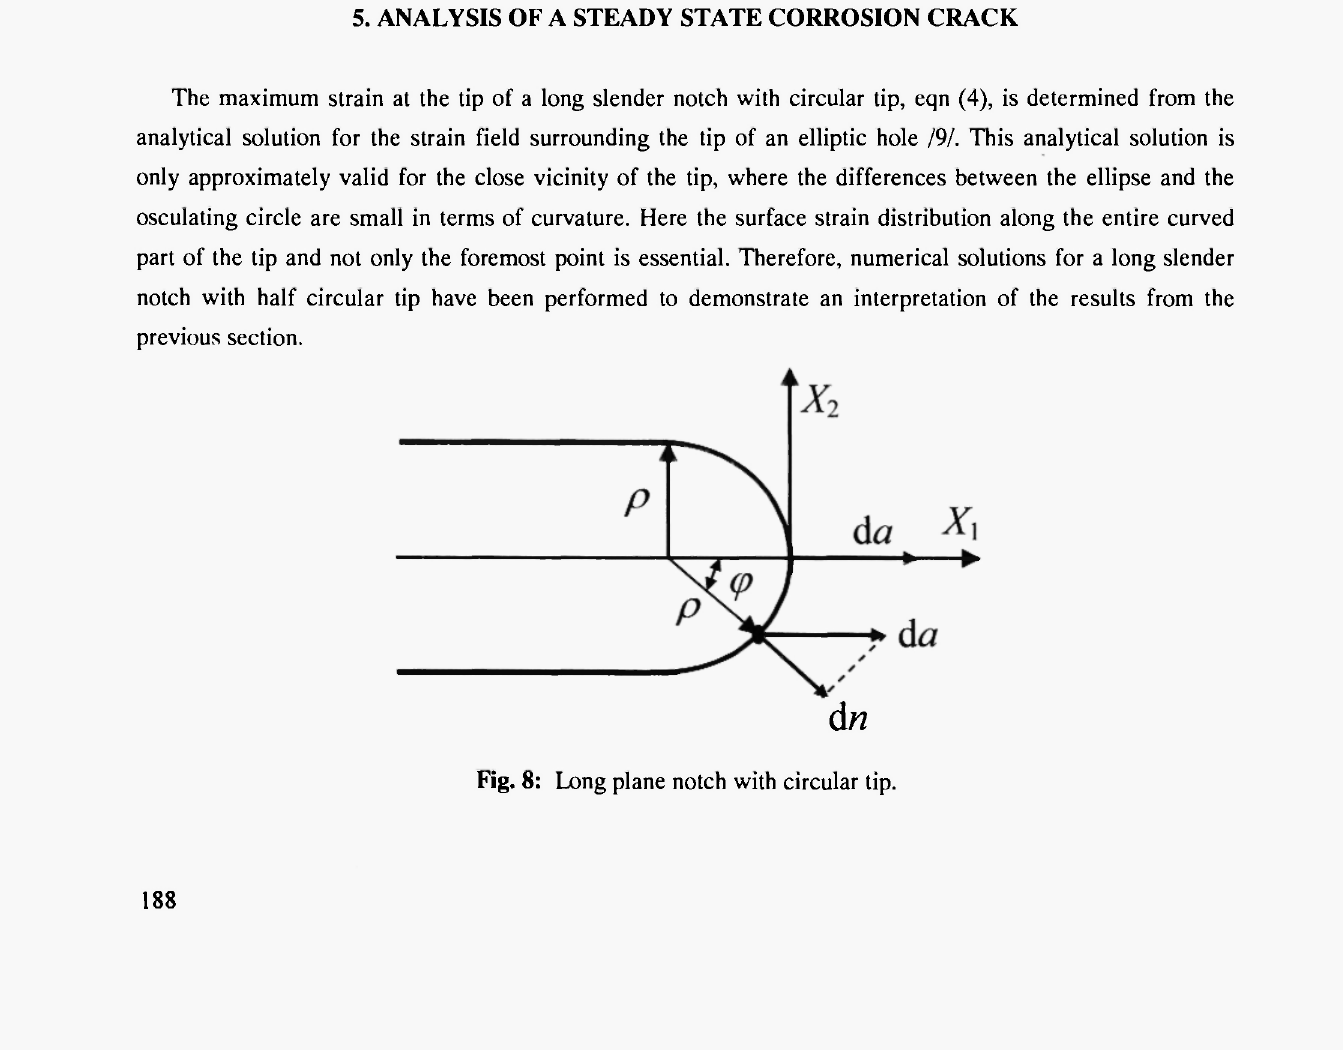
Fig. 7: Shape factor vs. yield strength.